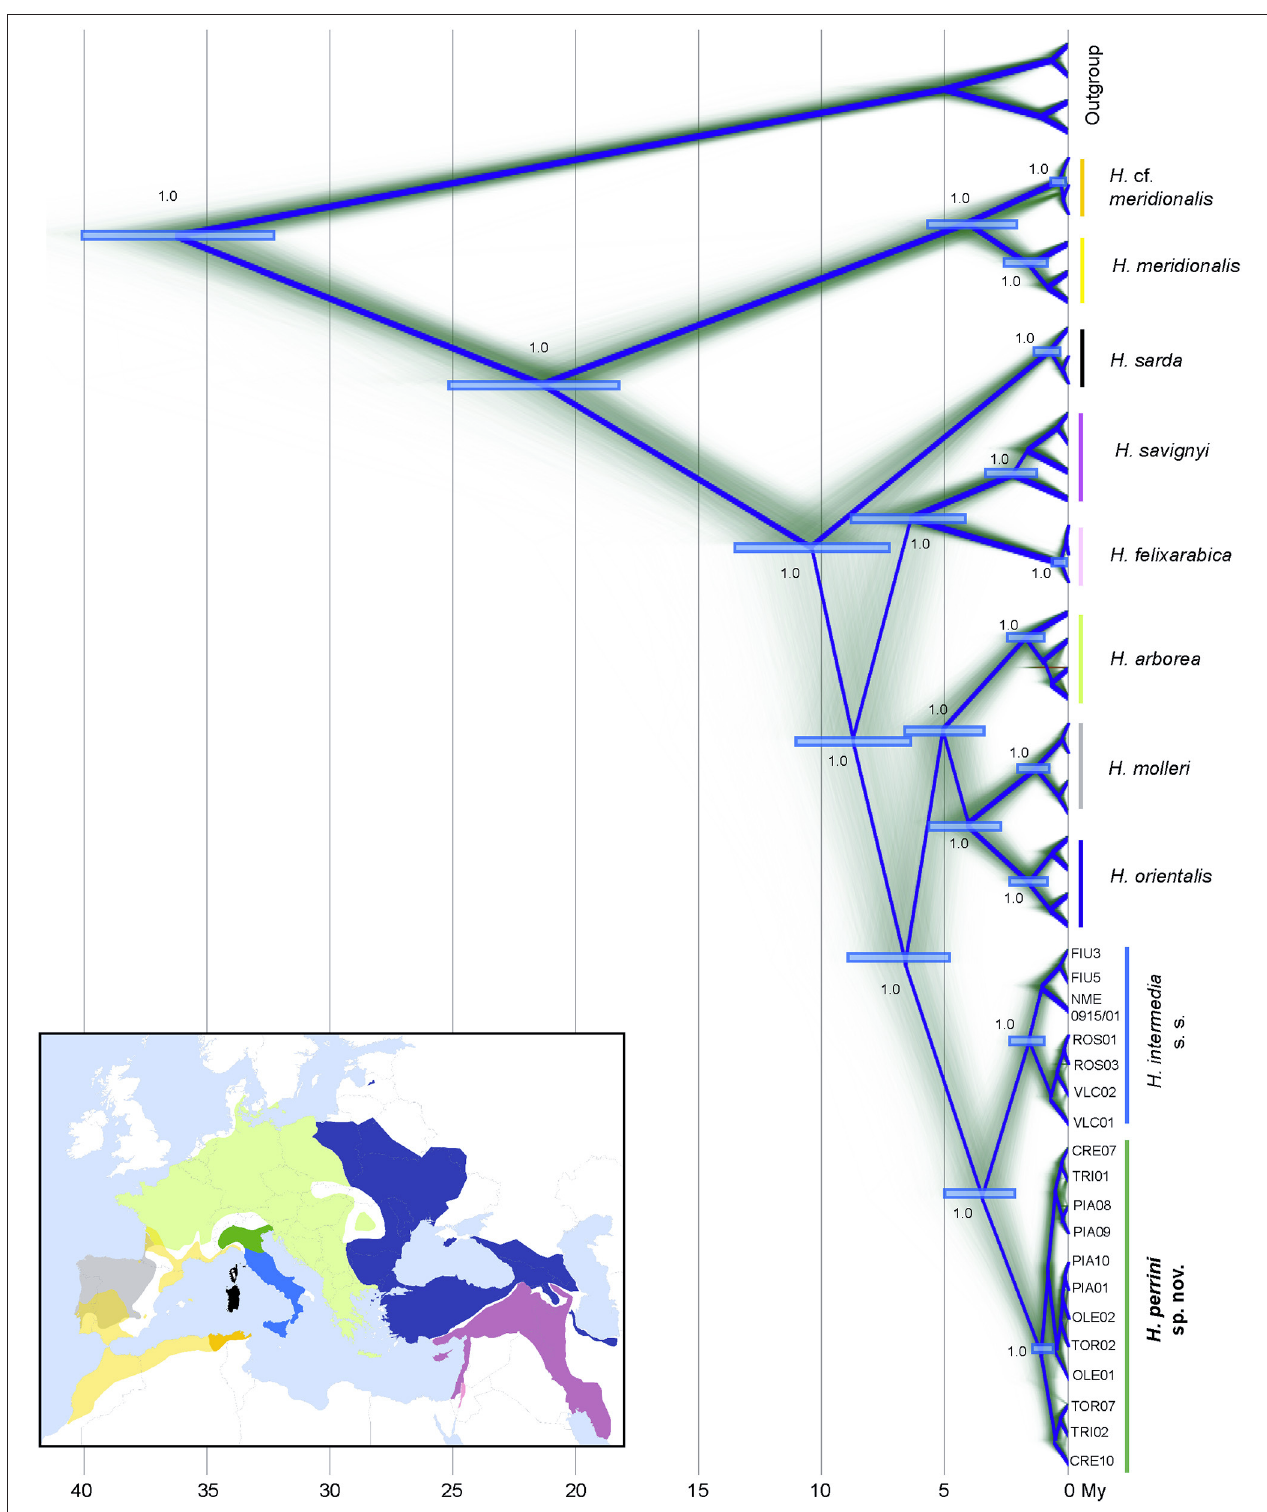
FIGURE 2 | Time-calibrated phylogeny of nuclear loci (42,834 bp from 621RAD tag sequences). Clock rate averaged 3.8e − 4 substitutions/site/My. Diffuse lines show branches of the sampled trees, summarized by the root canal (blue framework). For major nodes, the Bayesian posterior probabilities and confidence intervals of divergence times are indicated. Species distributions use the color codes shown on the tree. Species distributions use the color codes shown on the tree. The map was built in QGIS 2.18 using map layers from ESRI and the IUCN red list (adapted by Dufresnes, 2019). The polytypic H. japonica was used as outgroup ( Table S1B ).